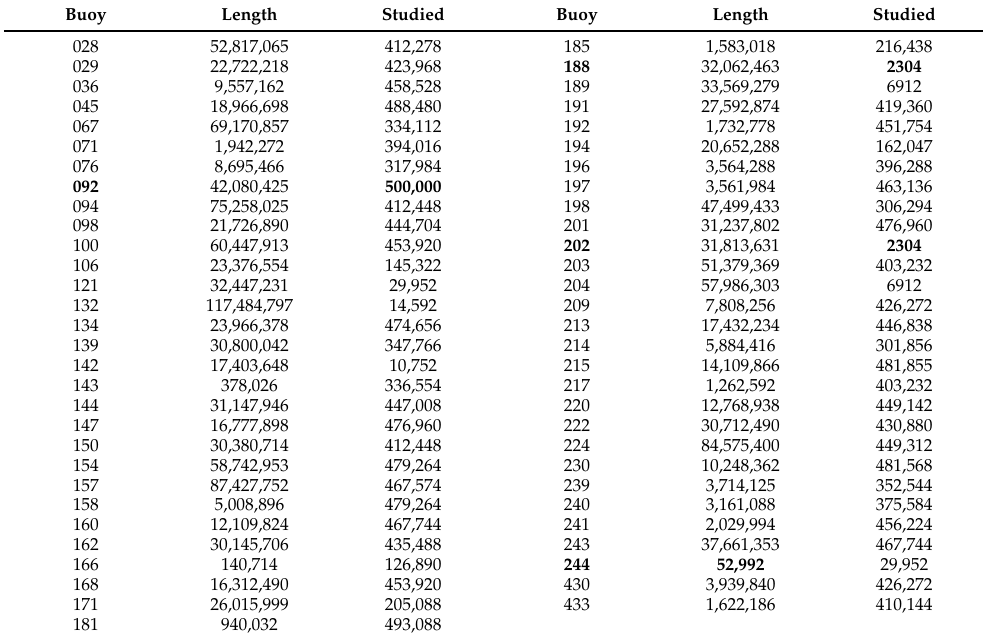
Table A2. The 59 available buoys are labelled by an identification number in descending order. The length of the associated time series is also reported, the smallest being highlighted in bold. The studied label represents the length of the studied time series after selecting the first 5 × 10 5 time points and eliminating the unobserved, missing, values.